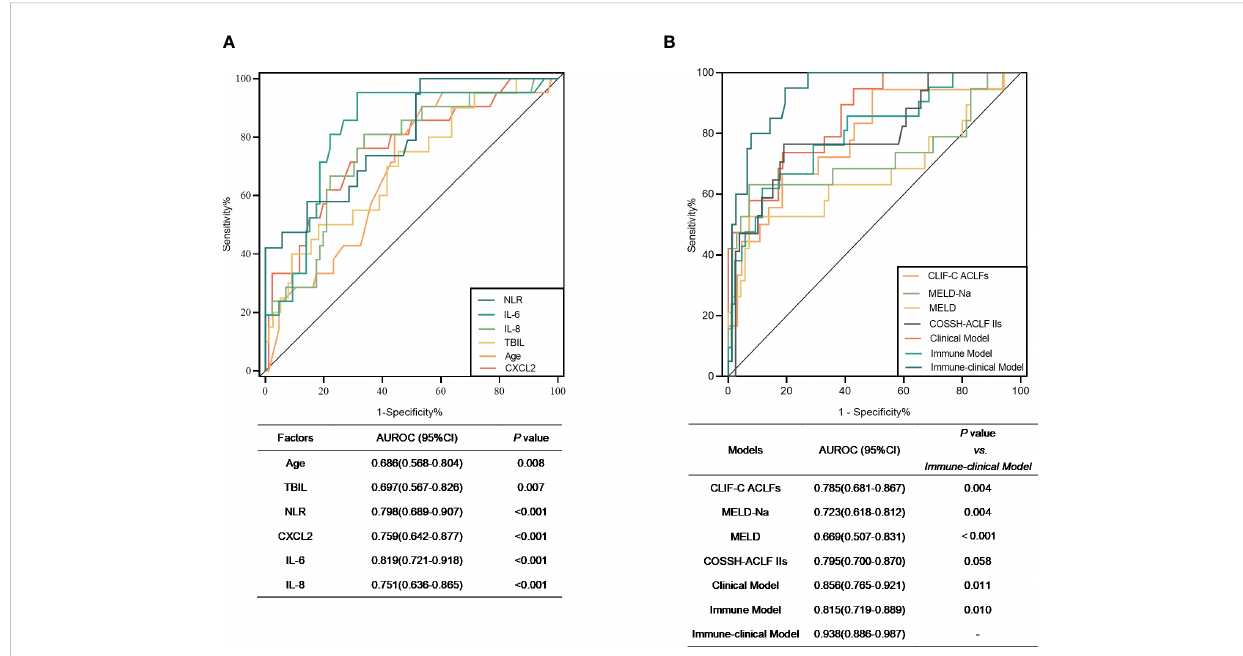
FIGURE 3 (A) Receiver operating characteristic (ROC) curves of the signi fi cant factors that distinguished non-survivors from survivors. (B) ROC curves of Model for End-Stage Liver Disease (MELD), MELD-Na, and Chronic Liver Failure Consortium on Acute-on-Chronic Liver Failure (CLIF-ACLFs) and the three models in the prognosis prediction of hepatitis B virus-related acute-on-chronic liver failure (HBV-ACLF). Clinical model = − 8.967 + 0.088 × Age + 0.005 × TBIL ( m mol/L) + 0.457 × NLR. Immune model = − 5.379 + 0.024 × CXCL2 + 0.023 × IL-6 + 0.014 × IL-8. Immune-clinical model = − 21.820 + 0.139 × Age + 0.013 × TBIL ( m mol/L) + 0.061 × CXCL2 + 0.015 × IL-8. AUROC , area under the receiver operating characteristic curve; TBIL , total bilirubin; NLR , neutrophil-to-lymphocyte